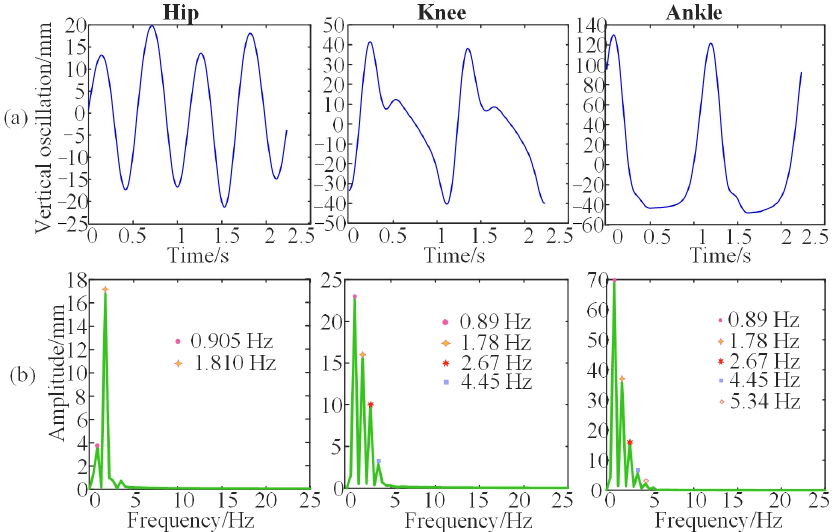
Figure 5. The vertical displacement and the spectrum of the joints for one subject. ( a ) The vertical oscillations of hip, knee, and ankle. ( b ) The spectrums of vertical oscillations of hip, knee, and an- kle.